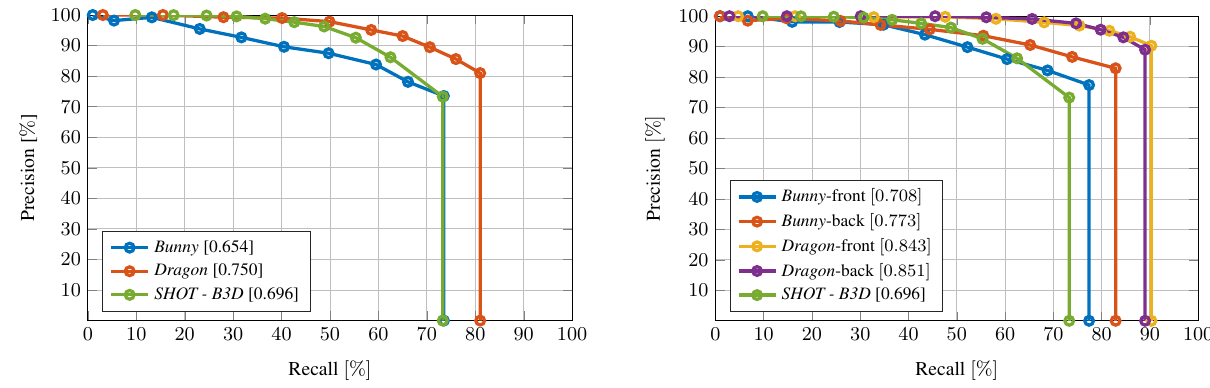
Figure 4. Results of the learned low-dimensional feature descriptor on the B3R dataset models Bunny and Dragon compared to the results of the SHOT descriptor on all models as reported by Yang et al. (2017). Values in squared brackets denote the AUC. Left : Performance after learning the model for 11 epochs on the training dataset. Right : Performance after fine-tuning the model for 3 epochs ( Bunny ) and 1 epoch ( Dragon ), respectively. Bunny -front denotes that the NN was fine-tuned using the Bunny -back and tested on the Bunny -front. Interpretation of the other labels is correspondingly.